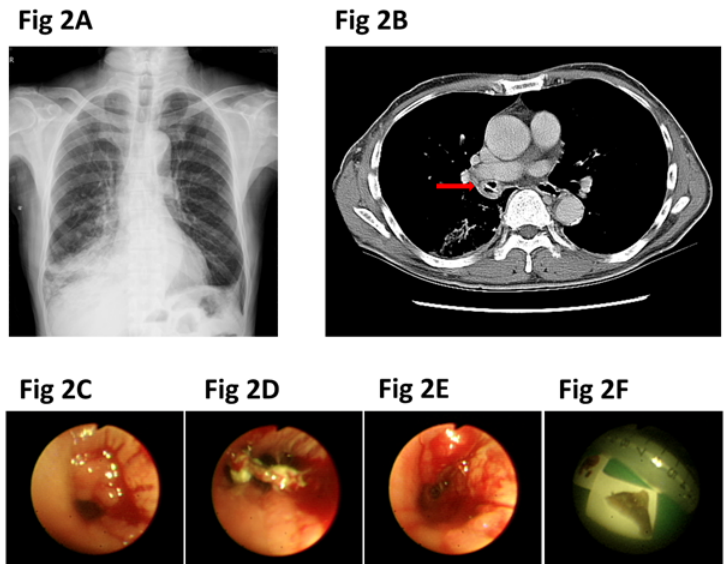
Fig 2. (A) Atelectasis of the right lower lung. (B) Foreign body in the right intermediate bronchus. (C) Granulation tissue covered the foreign body. (D) Bony foreign body after removing the granulation tissue by cryotherapy and forceps. (E) A patent right intermediate bronchus is noted after foreign body removal. (F) The foreign